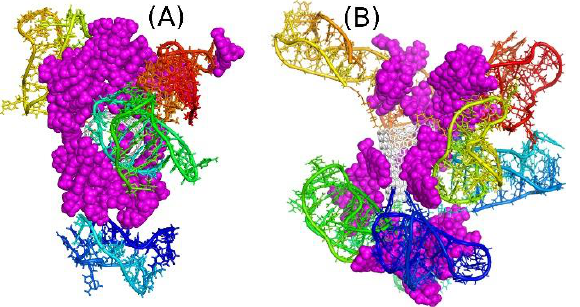
Figure 7. ( A ) The structure of the system I2A after 50 ns of simulations; ( B ) the structure of the system I4A after 50 ns of simulations.